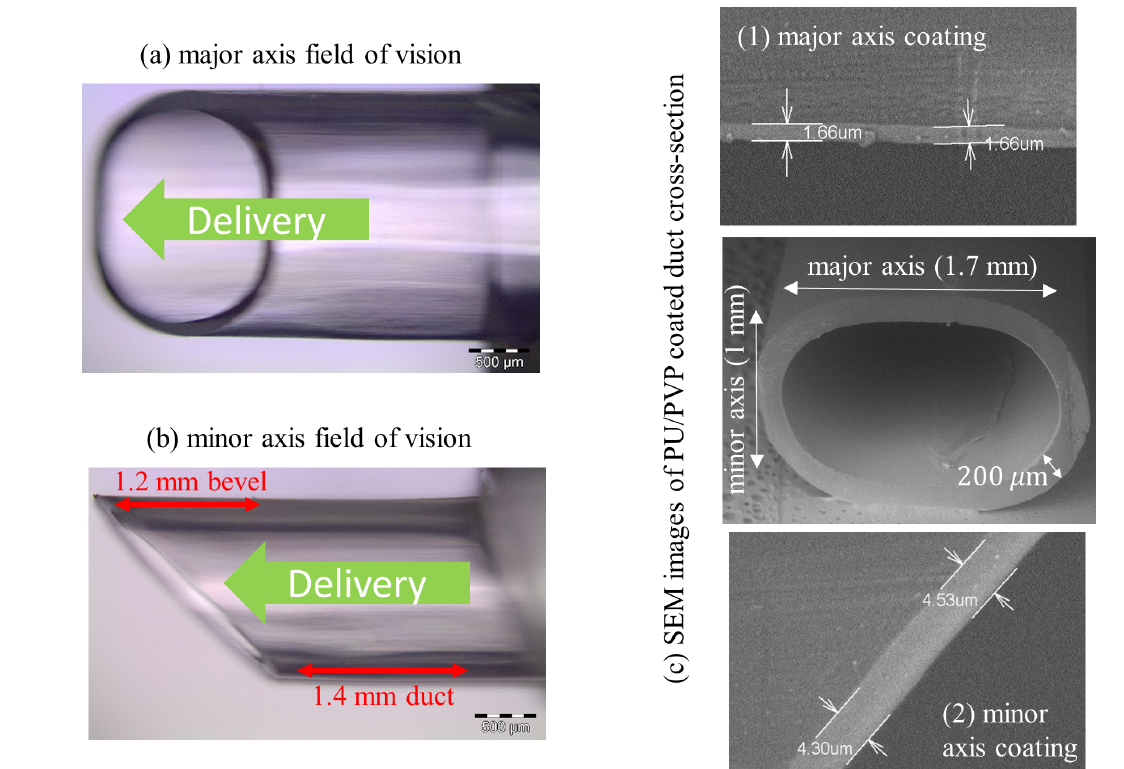
Figure 1. Sample delivery device interface: elliptical duct with a bevel tip. The inner wall of the tubing is coated with a thin film coating of a combination of PVP and PU. The PP body and PVP/PU coating are transparent in the visible. Darkfield reflection images from a visible microscope with a × 5 objective of ( a ) major and ( b ) minor axes views are shown on the left. ( c ) SEM images of a cross-section from the duct is shown on the right. The thickness of coating at selected segments of the (1) major and (2) minor axes of an industrially coated sample is also shown. Coating thickness is highest on the minor